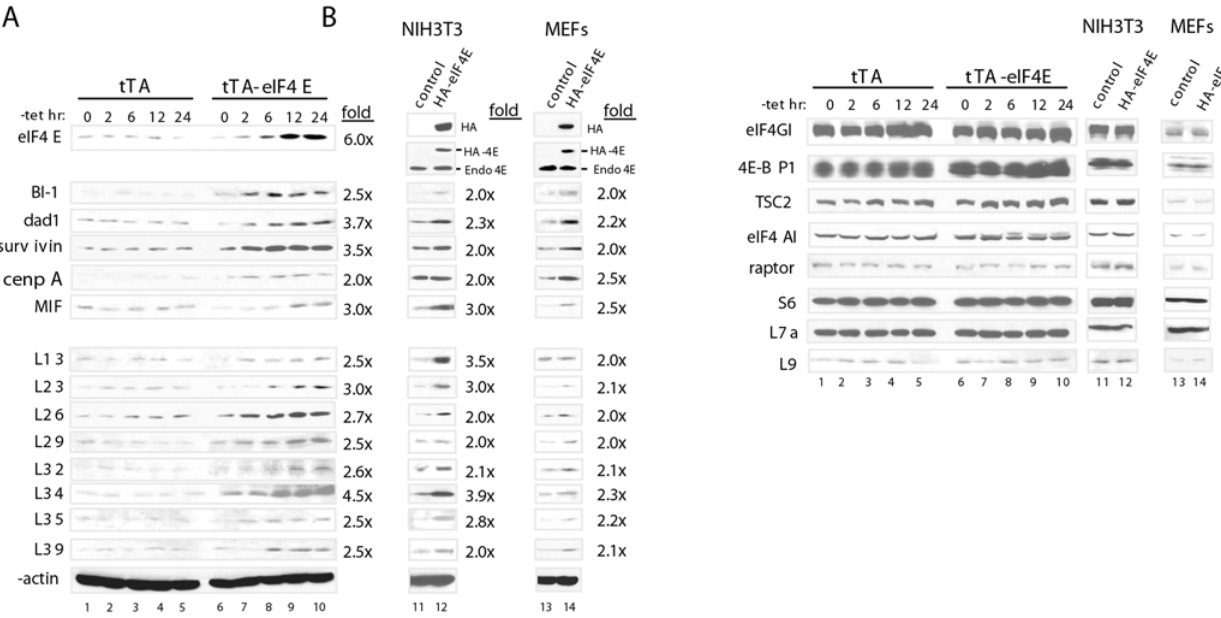
Figure 2. eIF4E induction stimulates the translation of a subset of mRNAs. A ) Western blotting of extracts from 3T3-tTA versus 3T3-tTA-eIF4E cells after eIF4E induction (0 to 24 hr) and from NIH 3T3 cells and MEFs that constitutively express HA-eIF4E or vector alone. eIF4E induction was determined by using anti-HA and anti-eIF4E antibodies. Fold increase at the 24 hr time point was determined using NIH Image. B ) Western blotting experiments were performed as described in (A). These experiments were repeated three times using three different sets of whole-cell extracts.